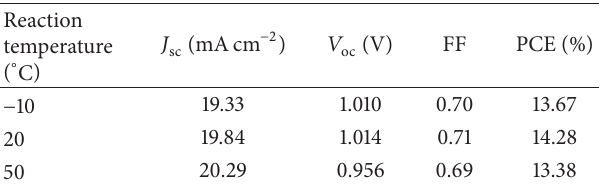
Table4:Electricaldatafor − 10 ∘ C,20 ∘ C,and50 ∘ C.Reproducedfrom [24] with permission from the Royal Society of